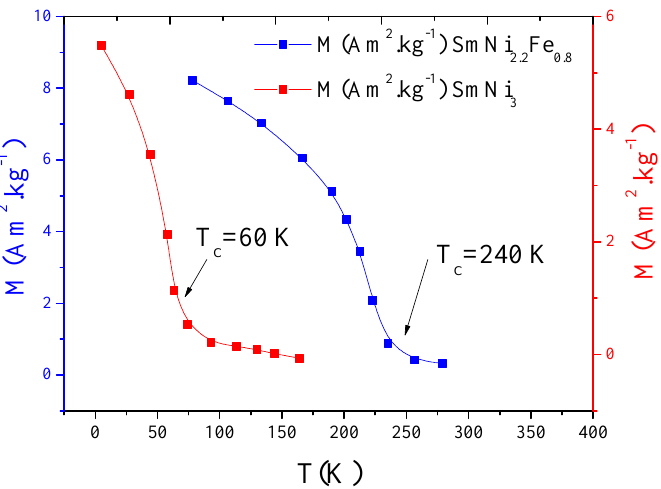
Figure 4. Magnetization plotted against temperature for SmNi 3 (red y -axis) and SmNi 2.2 Fe 0.8 (blue y -axis).